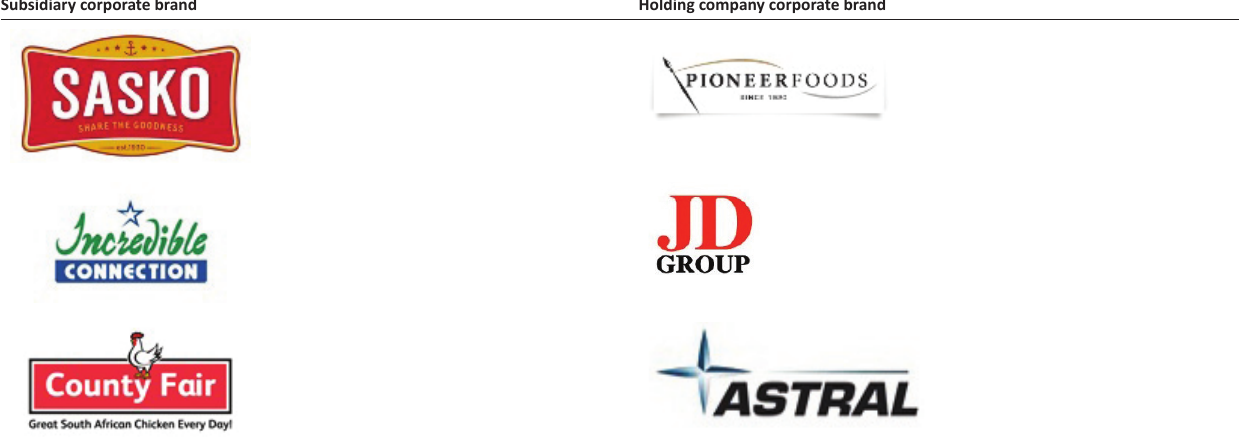
TABLE 4: Corporate listed brands of holding companies and their subsidiaries. Subsidiary corporate